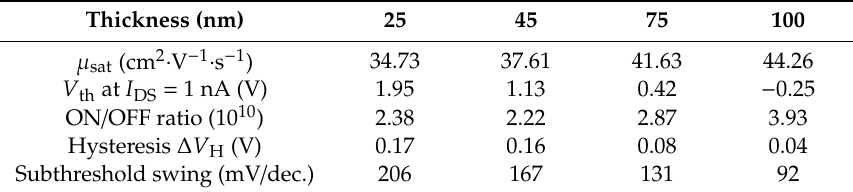
Figure 1. Transfer properties of ( a ) 25, ( b ) 45, ( c ) 75, and ( d ) 100 nm T ITZO -varied TFTs measured at V DS = 10.1. Table 1. The extracted parameters of T ITZO –varied TFTs in the forward scan.